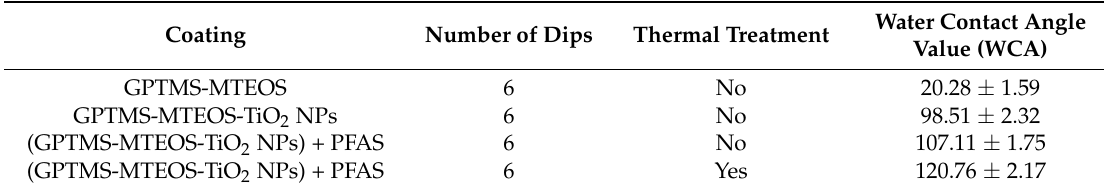
Table 3. Summary of the different sol-gel hybrid coatings with their corresponding water contact angle (WCA) values before and after thermal treatment with the incorporation of PFAS metal alkoxide precursor.